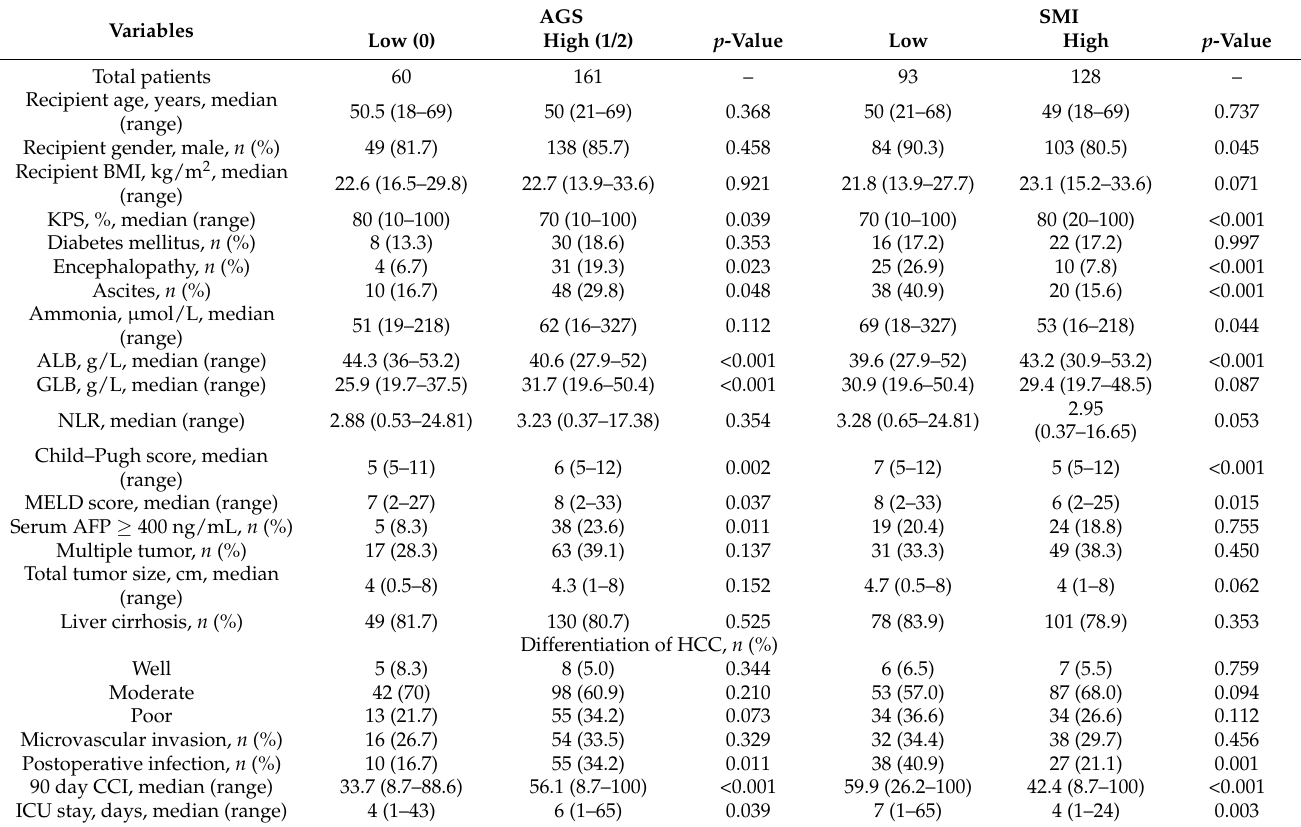
Table 2. Correlation among AGS, SMI, and clinicopathological characteristics of HCC patients who underwent